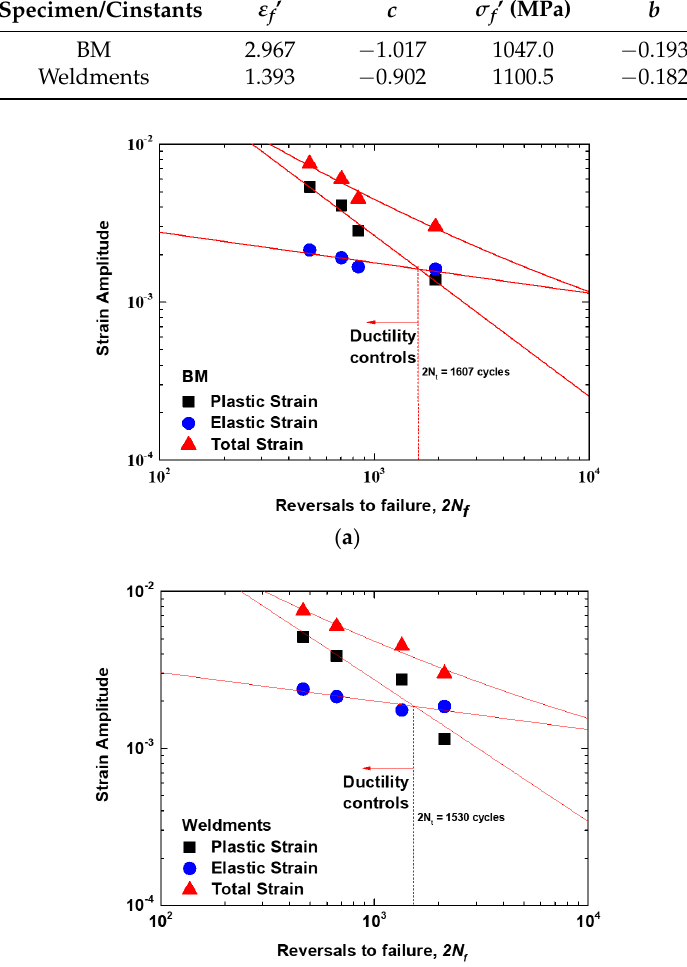
Figure 8. The Coffin–Manson–Basquin (CMB) curves of Alloy 800H: ( a ) BM and ( b ) weldments.